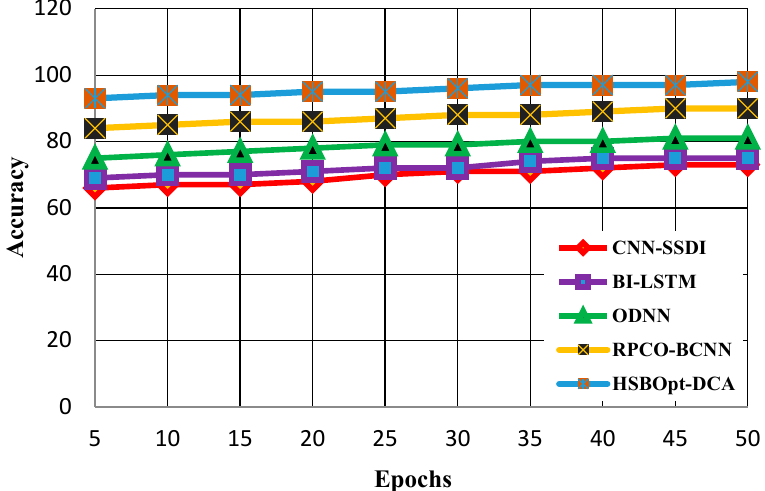
Figure 3. Accuracy calculation with 50 epochs.